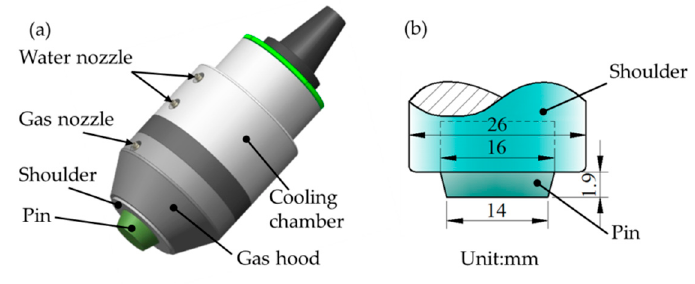
Figure 3. Schematic of FSW tool. ( a ) Schematic for friction tool structure, ( b ) dimensions of the friction head.